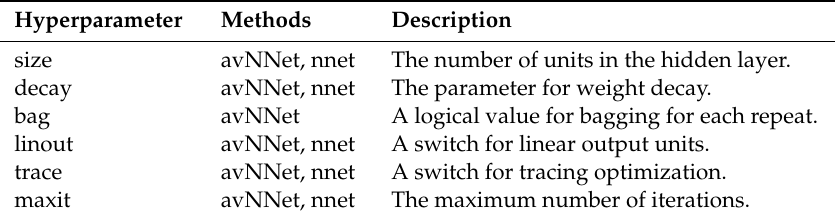
Table 4. Neural networks